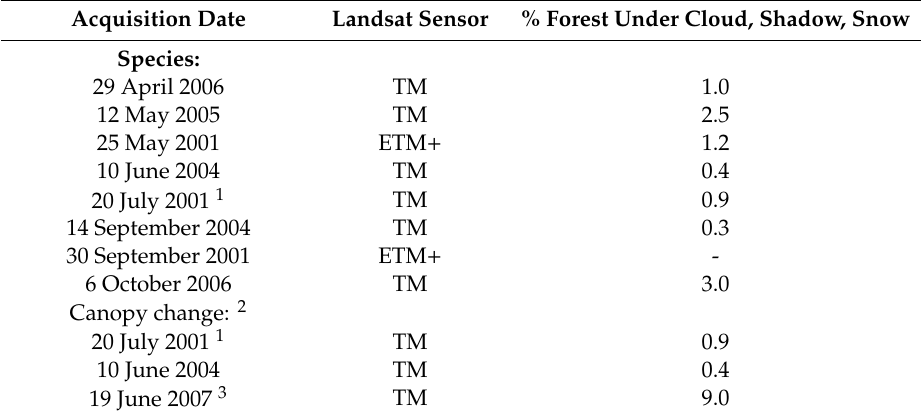
Table 1. Landsat images used for predictive modeling of tree species relative abundance. Images were acquired over Landsat Worldwide Reference System-2 path 12, row 28, and were obtained from the U.S. Geological Survey Earth Resources Observation and Science Center unless indicated